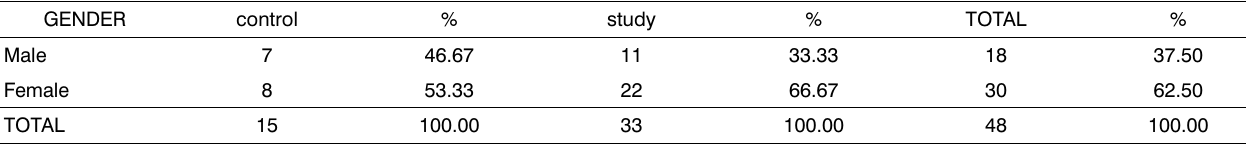
Table 1. Gender distribution in the control and study groups.